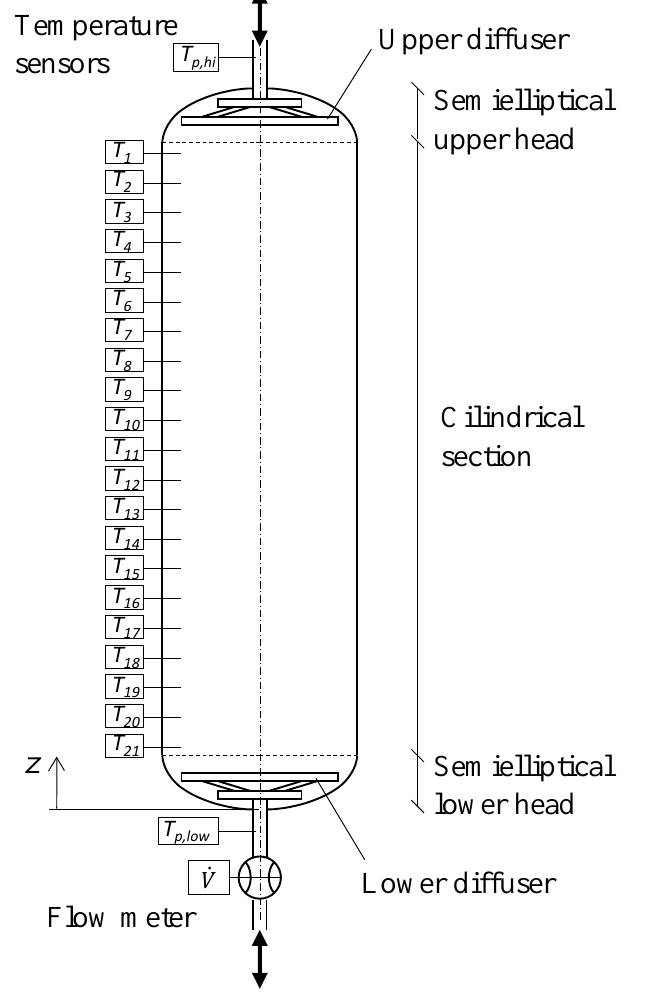
Figure 2. Thermal energy storage device with the sensors of the process data acquisition system. Data in Figure 3 was obtained from the acquisition system. It is represented by means of charts with the time evolution of the flow rate and pipe temperatures. Instant profiles from the immersion temperature sensors are also represented. Profiles in Figure 3 correspond to one representative 24 h period in which three different situations happen. They were: one approx 9 h charge period, one 11 h discharge, and a final storing period. Positive flow rates can be observed during the first 9 h in Figure 3a. Hot water enters the upper diffuser with the represented temperature an flow rate. At this instant flow changes to negative values corresponding to the discharge with a flow near to 20 m 3 entering the h lower diffuser. Mass flow rate and inlet temperature fluctuate for two hours under the control system commanding. Almost two hours of zero mass flow rate that are at the end of the 24 h period correspond to the storing part of the